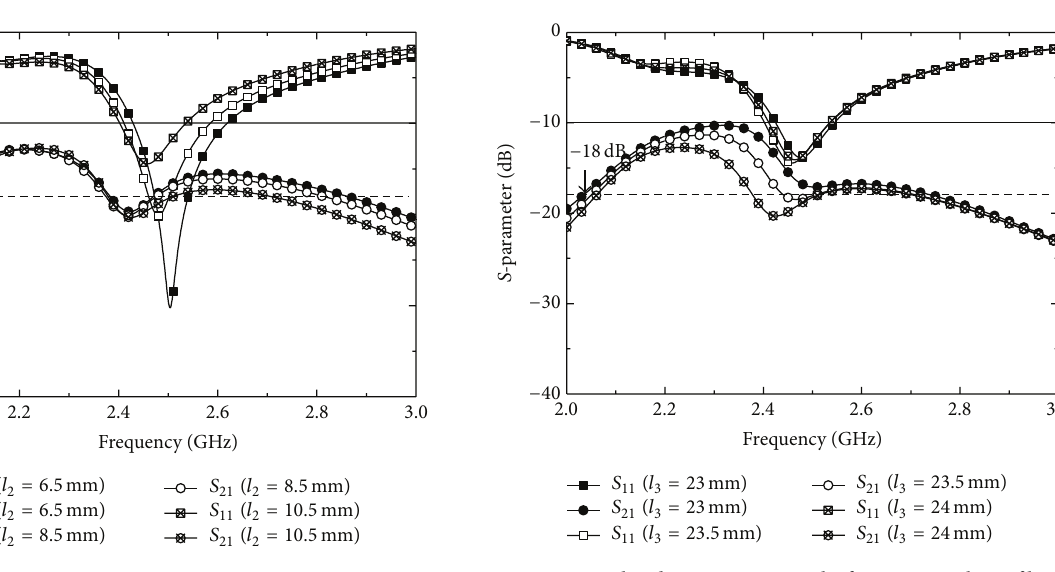
Figure 7: Simulated 𝑆 -parameter results for various values of length 𝑙